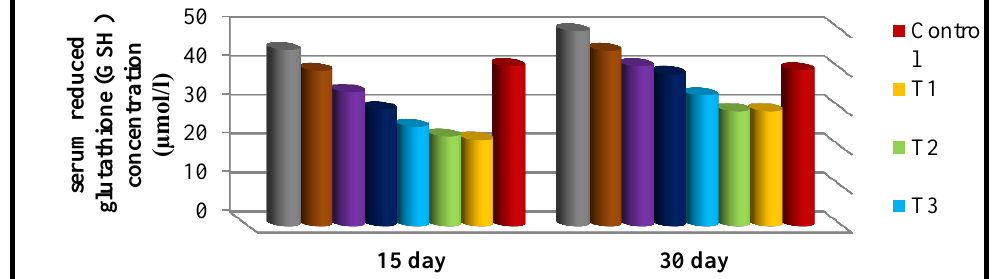
Figure 3: Effect of different doses of total polyphenol extracted from green tea for 15 and 30 days on serum reduced glutathione (GSH) concentration (µmol/l) of iron overload treated rats.